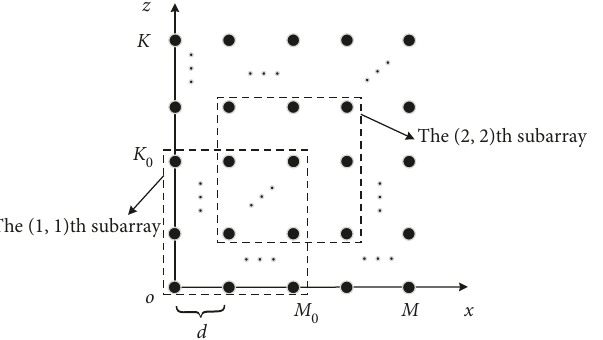
Figure 2: The subarray grouping of URA on the xoz